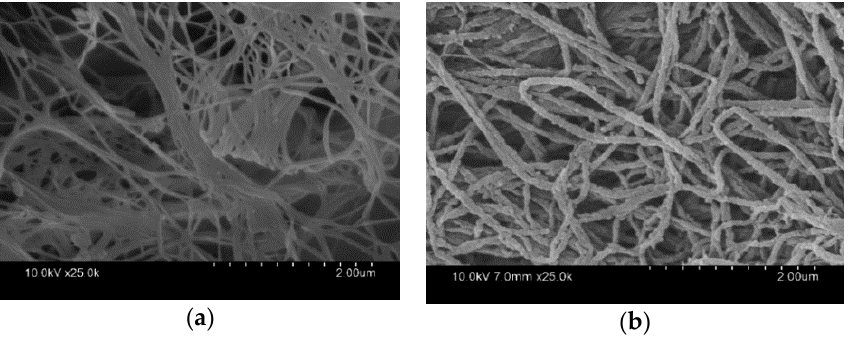
Figure 3. Scanning electron microscope (SEM) images of pure bacterial cellulose (BC) and PPy/BC composite: ( a ) pure BC membrane; ( b ) PPy/BC composite.